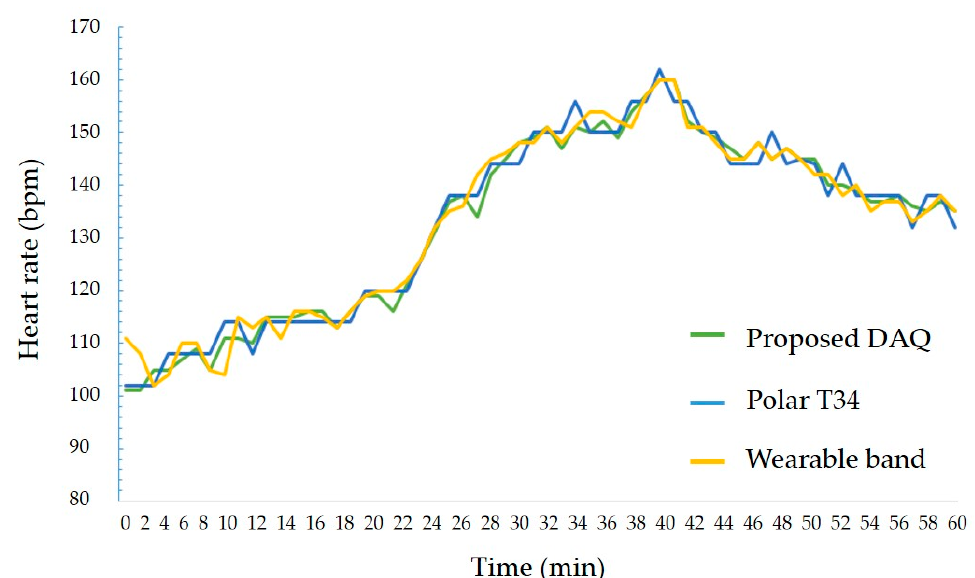
Figure 9. The experiment result of heart rate sensing between proposed DAQ and other counterparts.